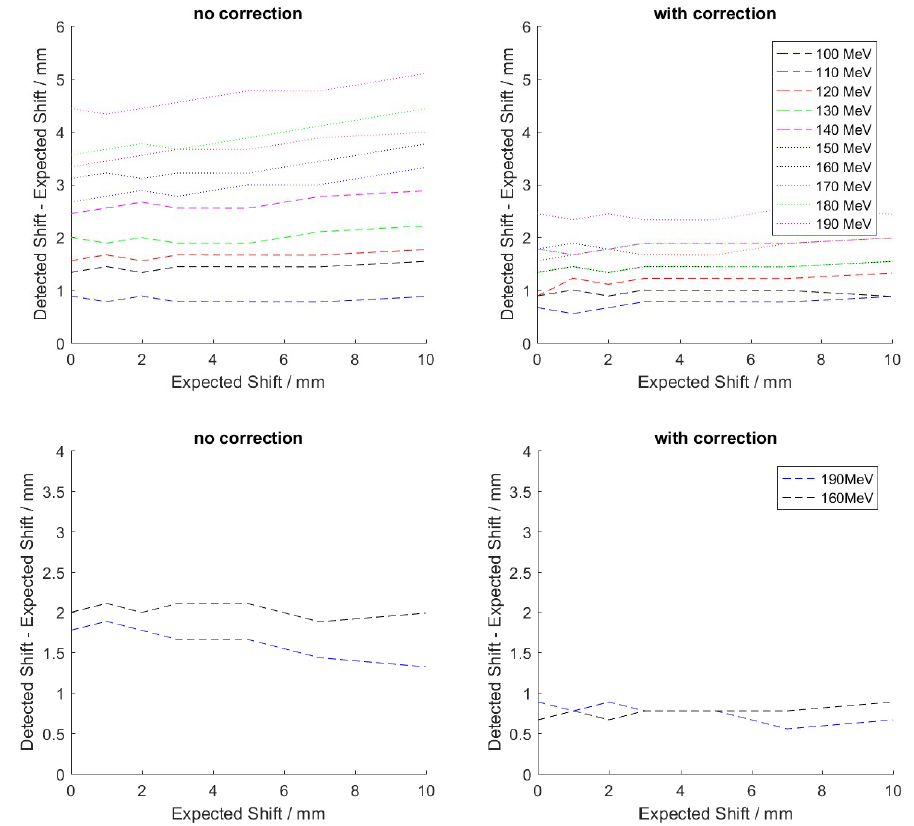
Figure 7. Detected shift minus expected shift as function of the expected shift for different camera setups ( top : 25:20, bottom 25:12) using data without ( left ) and with ( right ) geometrical correction.